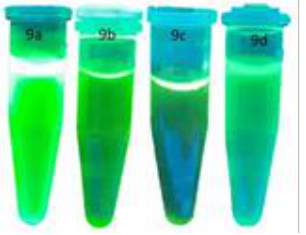
Figure 5. Blue light emission of 9a – d under 365 nm UV irradiation.